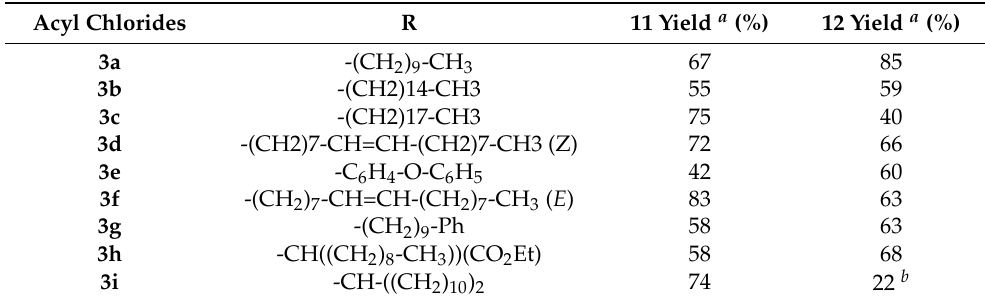
Table 3. Isolated yields for the synthesis of compounds 11a – i and 12a – i . Acyl